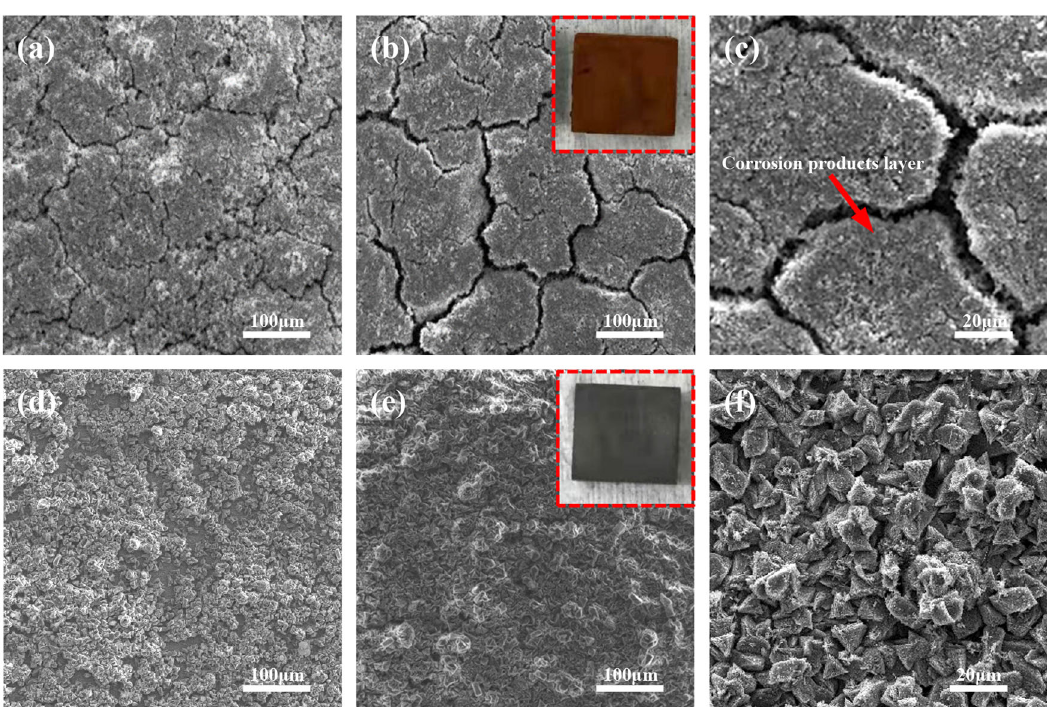
Fig. 1 SEM and optical images of the surface products on the Q235 coupons. a , b Q235 surface in the sterile medium after 7 days and 14 days; d , e Q235 surface in S. putrefaciens -inoculated medium after 7 days and 14 days. c Enlarged image of panel b . f Enlarged image of panel e